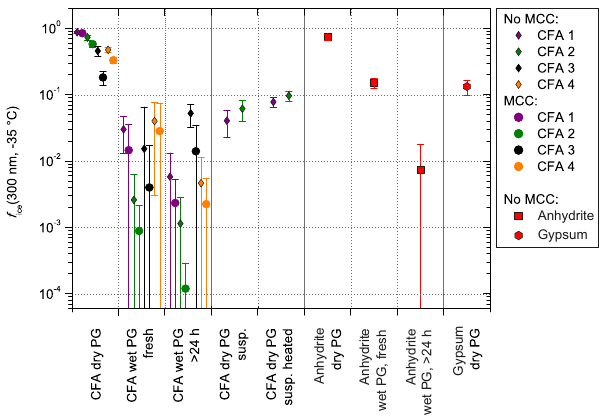
Figure 5. f ice ( − 35 ◦ C) from LACIS measurements with 300nm particles. Multiple charge correction (MCC) was not performed, ex- cept for the measurements indicated by the circles in the first three columns. “Dry PG susp.” means dry particle generation (PG) with a sample resulting from the evaporation of a suspension and “dry PG susp. heated” means additional heating of this sample to 250 ◦ C prior to particle generation.